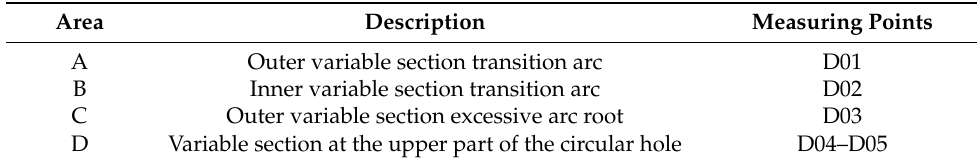
Figure 7. Measuring point locations: ( a ) one side view; ( b ) another side view. Table 1. List of measuring points.